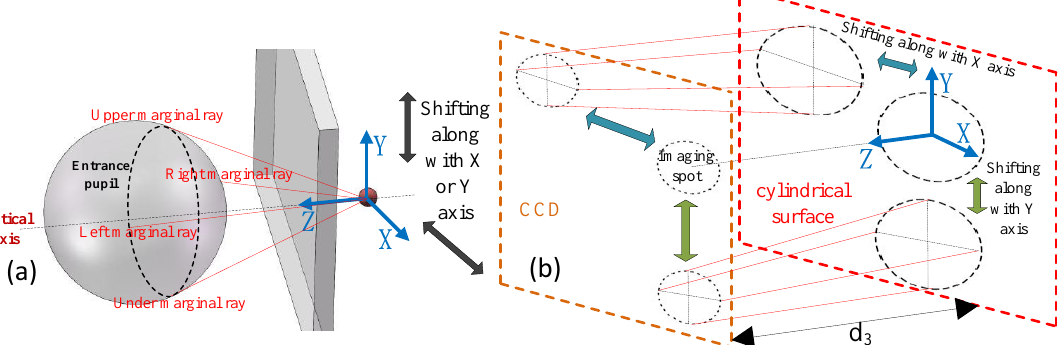
Figure 2. Valid pupil area determined using a cone of light propagating from one point on the surface of a nanoparticle: ( a ) valid entrance pupil, and ( b ) corresponding valid exit pupil.